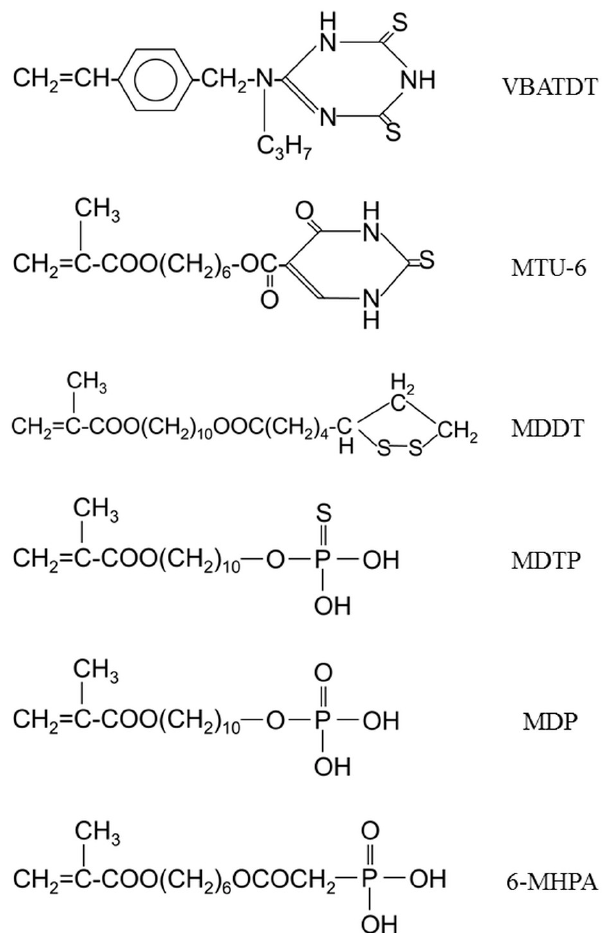
Figure 1. Chemical structures of four sulfur-containing monomers and two phosphoric acid monomers. Table 1. Materials used in the study.